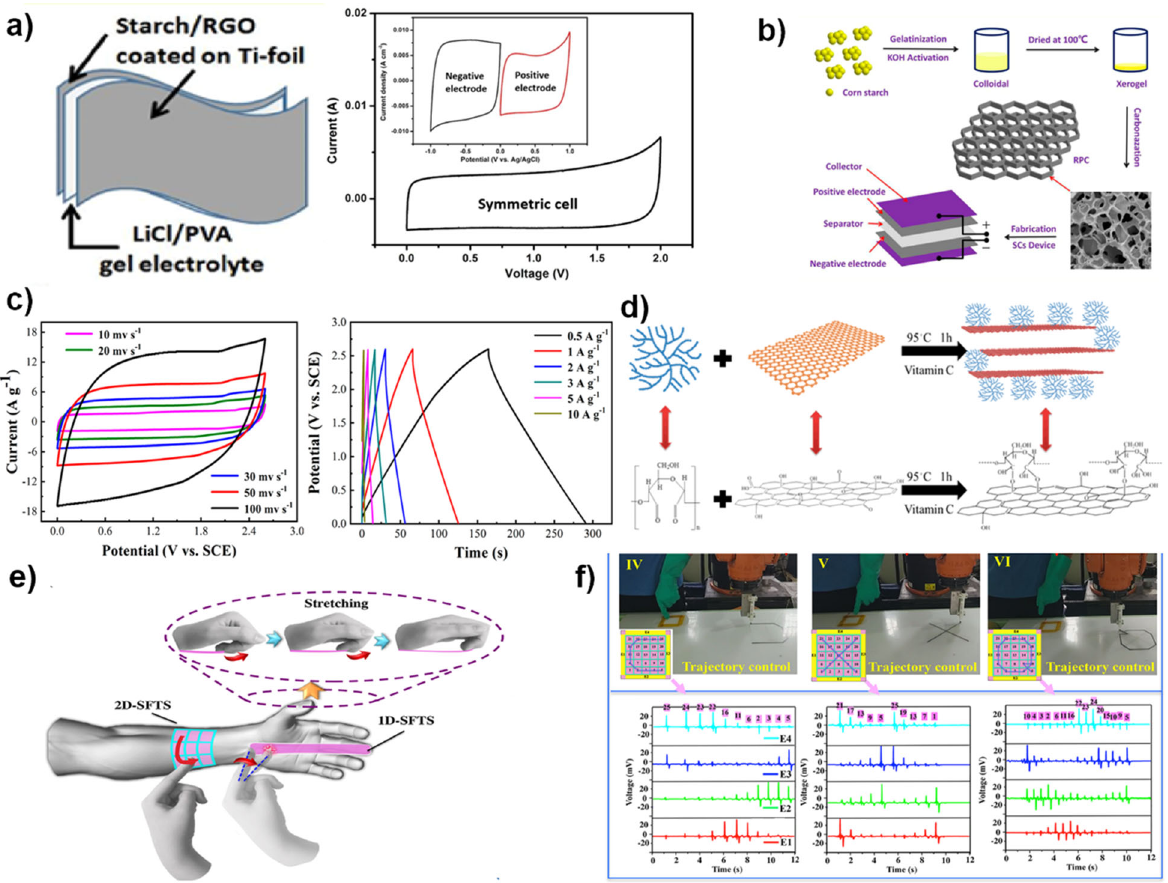
Fig. 9 Supercapacitor and nano generator based on starch gels. a Schematic diagram of supercapacitor and capacitive performances of starch/RGO and starch/RGO supercapacitor. Reproduced with permission 34 . Copyright 2017, American Chemical Society. b Schematic diagram and c electrochemical performances of the supercapacitor with a 3D printed electrode. Reproduced with permission 158 . Copyright 2019, American Chemical Society. d Aerogel made of GO and starch nanocrystal that can be used as supercapacitor electrodes and highly ef fi